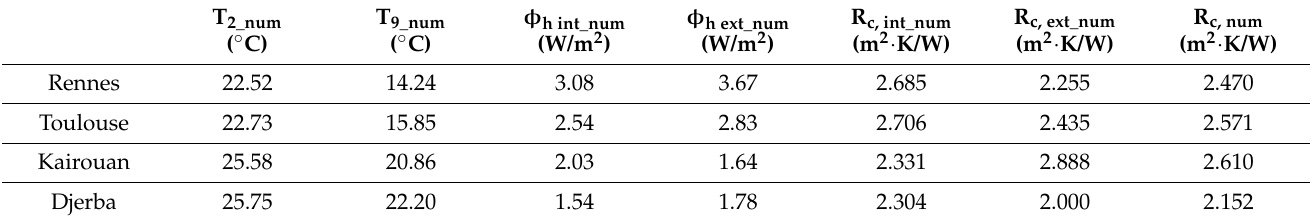
Table 5. Numerical heat fluxes and R c values at the end of the stabilization phase.